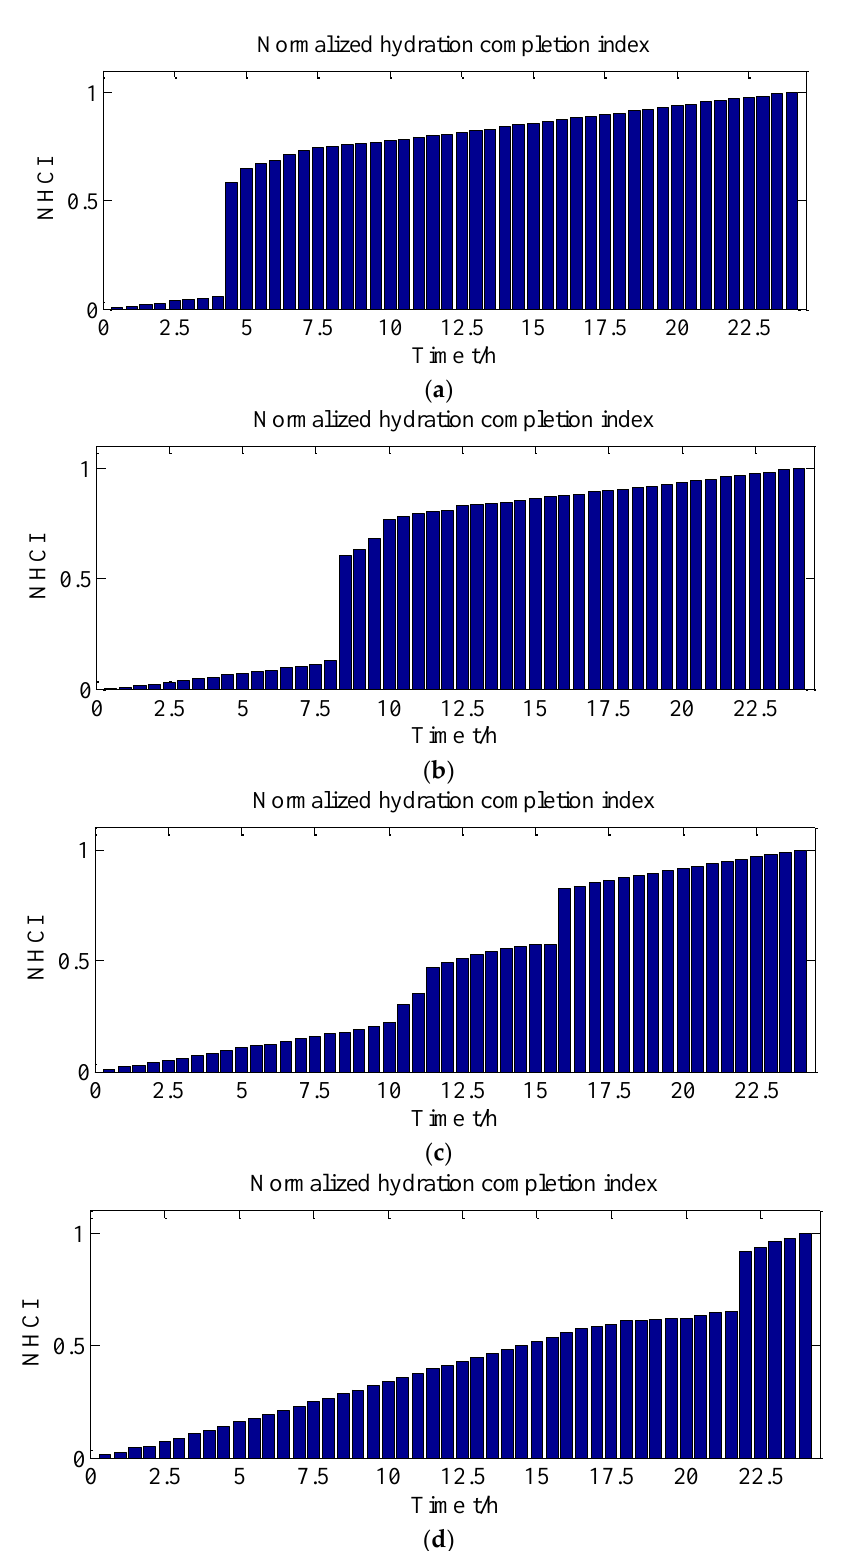
Figure 19. NHCI for SCCs with different volume of fly ash. ( a ) NHCI for FA-0%; ( b ) NHCI for FA-20%; ( c ) NHCI for FA-40%; ( d ) NHCI for FA-60%.